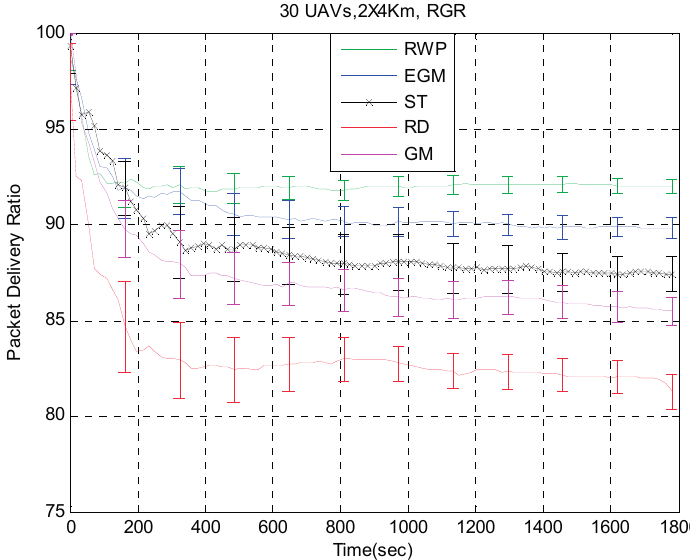
Figure 13. PDR of reactive-geographic hybrid routing (RGR) under various mobility